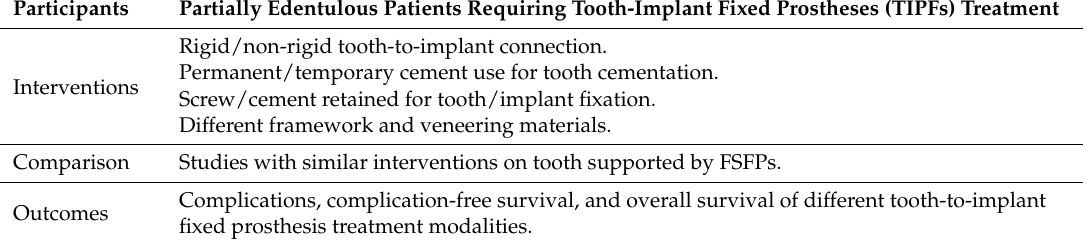
Table 1. PICO (Participants, Intervention, Comparison, and Outcome) Question used to focus literature